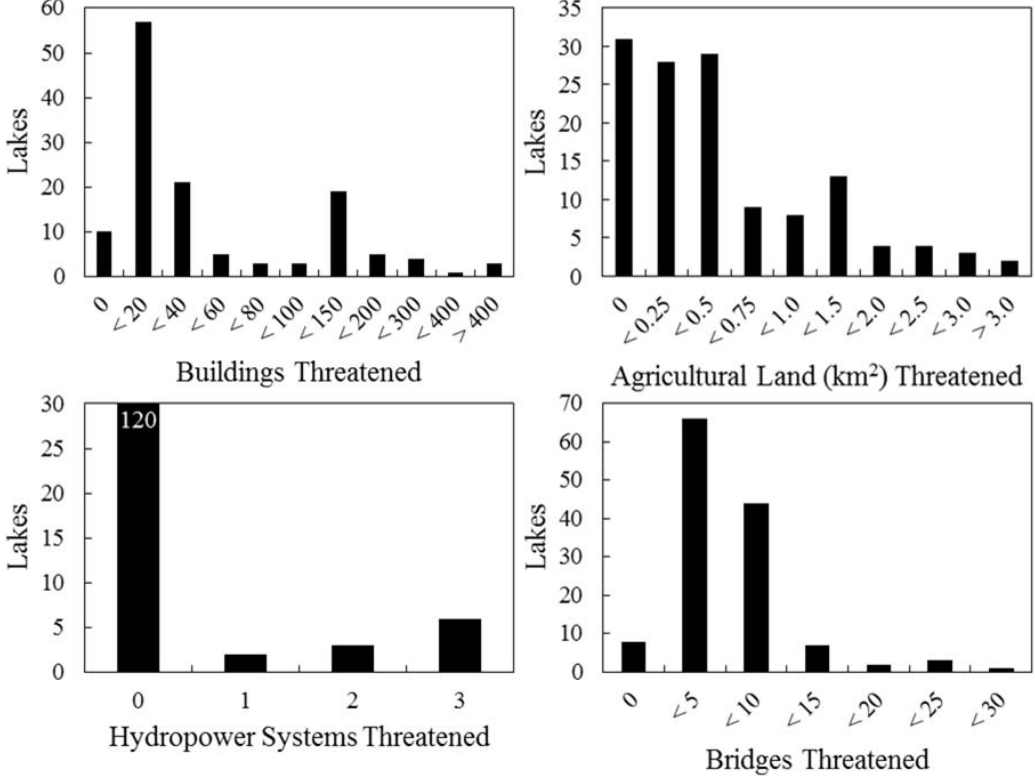
Figure 6. Summary of downstream impacts showing the number of buildings, agriculture (km 2 ), hydropower systems, and bridges threatened by